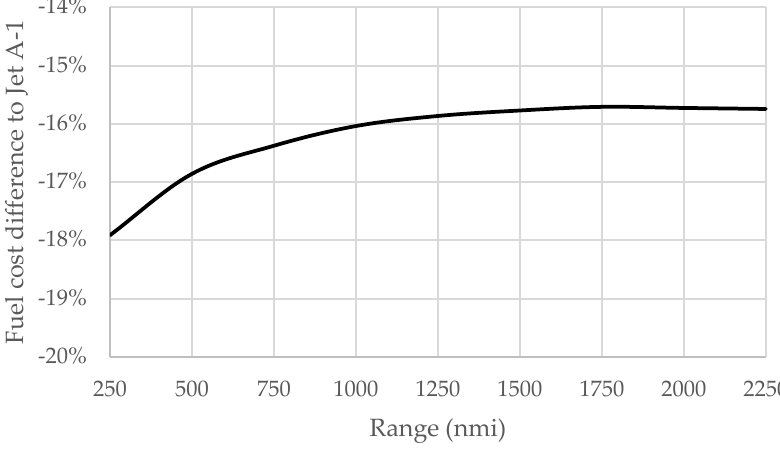
Figure 14. Average fuel cost difference to baseline Jet A-1.